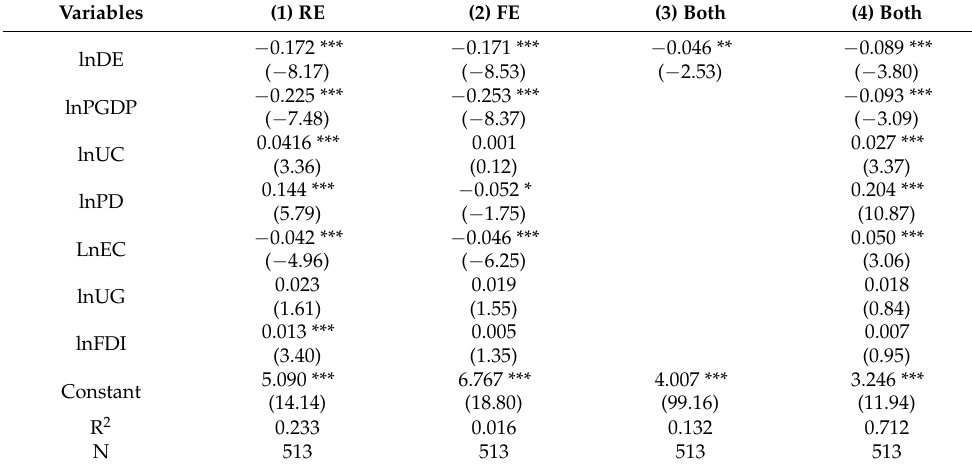
Table 3. Results of the baseline regression